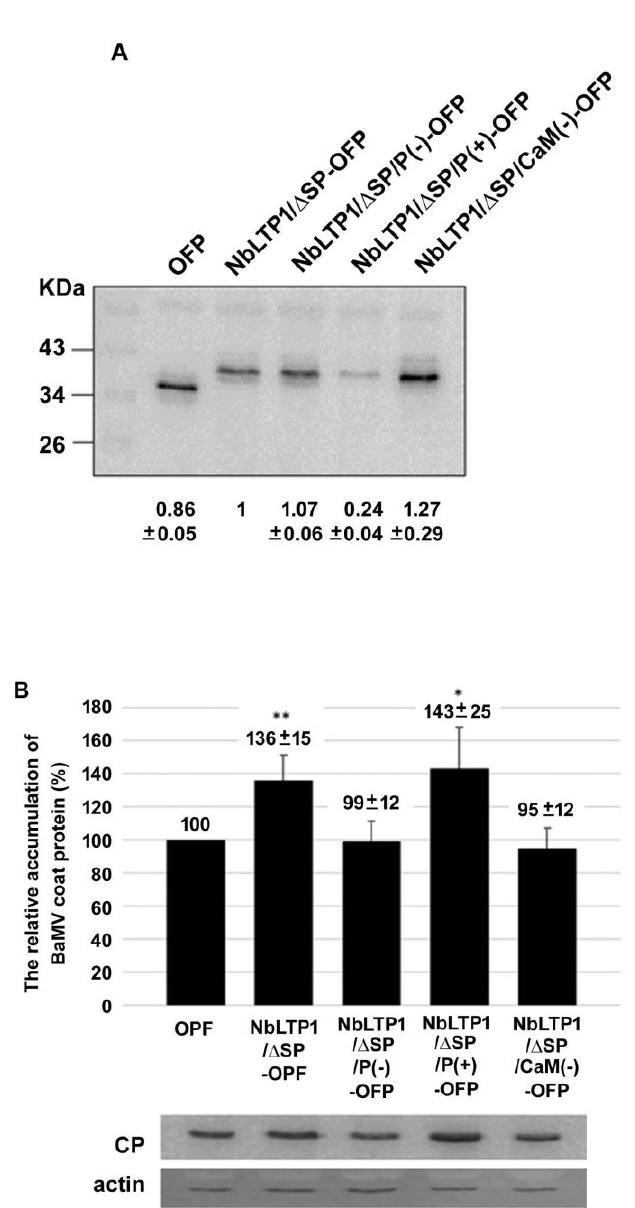
Figure 6. Relative accumulation of BaMV CP in NbLTP1 / ∆ SP-OFP and its derivatives transiently expressed in N. benthamiana . ( A ) Western blot analysis of protein levels of NbLTP1 / ∆ SP-OFP and its derivatives transiently expressed in N. benthamiana leaves by agroinfiltration. ( B ) The relative accumulation of BaMV CP in NbLTP1 / ∆ SP-OFP and its derivatives transiently expressed in leaves. The accumulation of BaMV in OFP-expressed leaves was set to 100%. Data are mean ± SE relative levels from at least three independent experiments. * p < 0.05, ** p < 0.01 by a Student’s t -test.